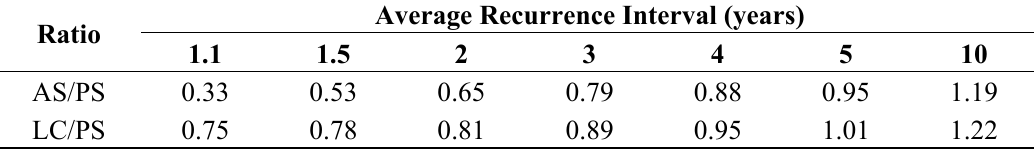
Table 3. Ratio of annual series estimates (AS) and Langbein adjusted annual series estimates (LC) to partial series (PS) estimates averaged across 13 North-Eastern Tasmanian stream gauging stations.